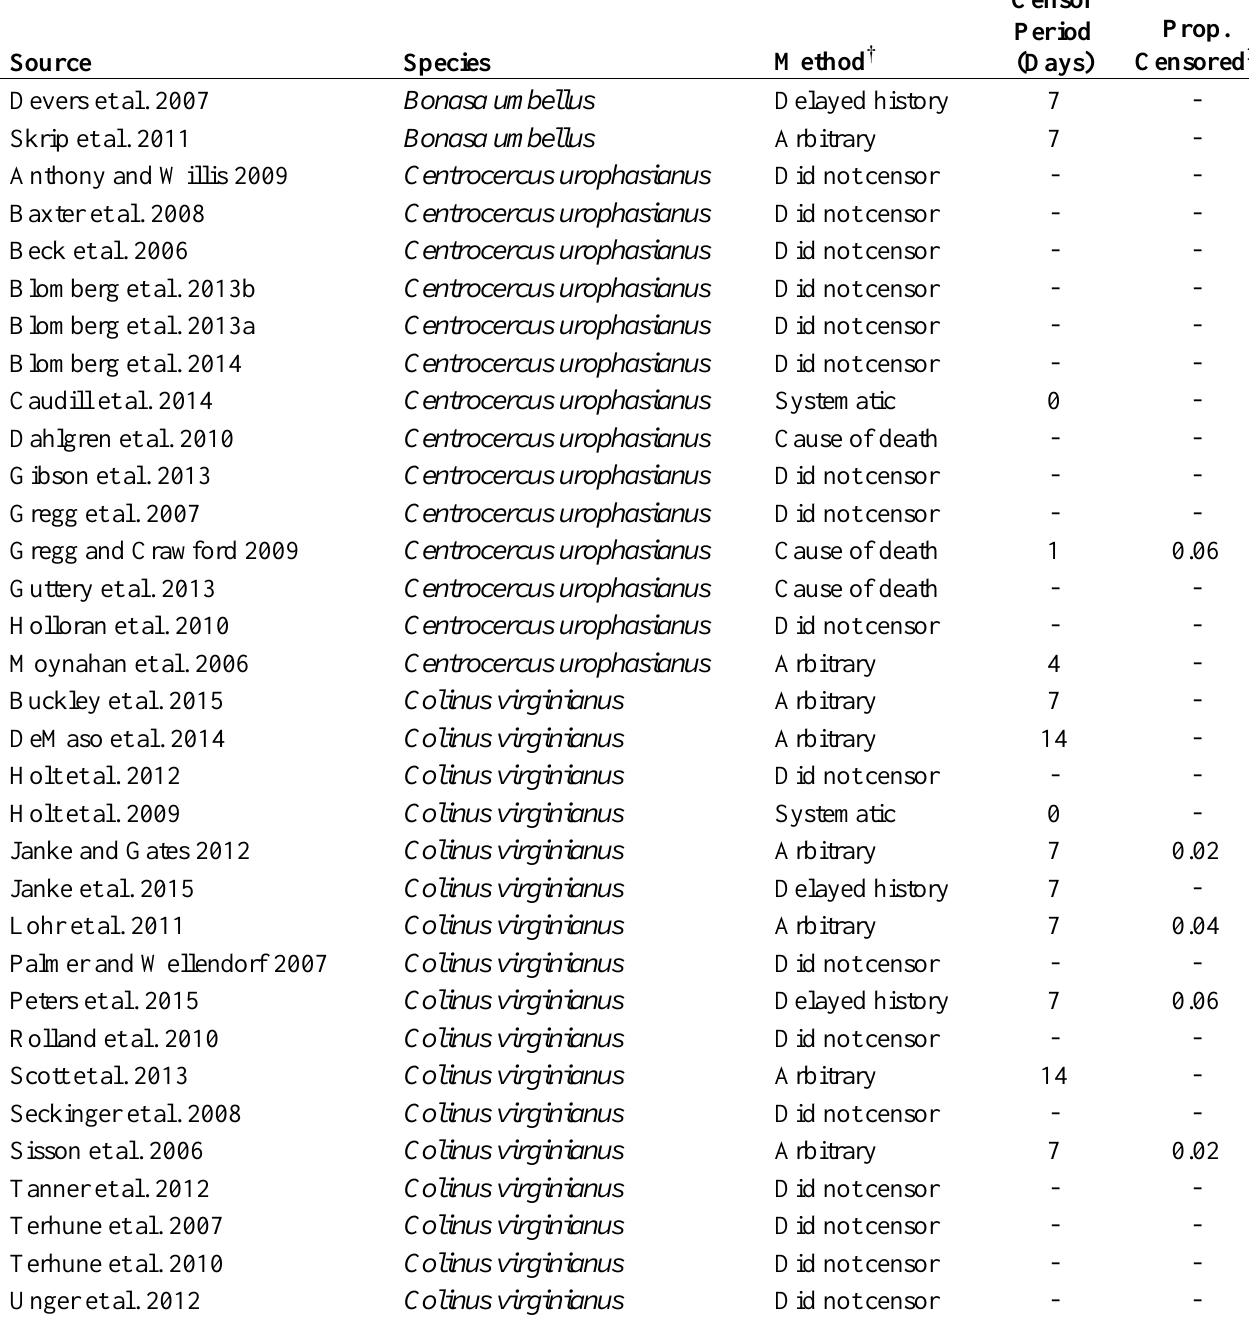
Table A1.1. Sources and information obtained during literature review to document researcher strategies for addressing capture-related mortality following release of radio-marked upland game birds from 2006 to